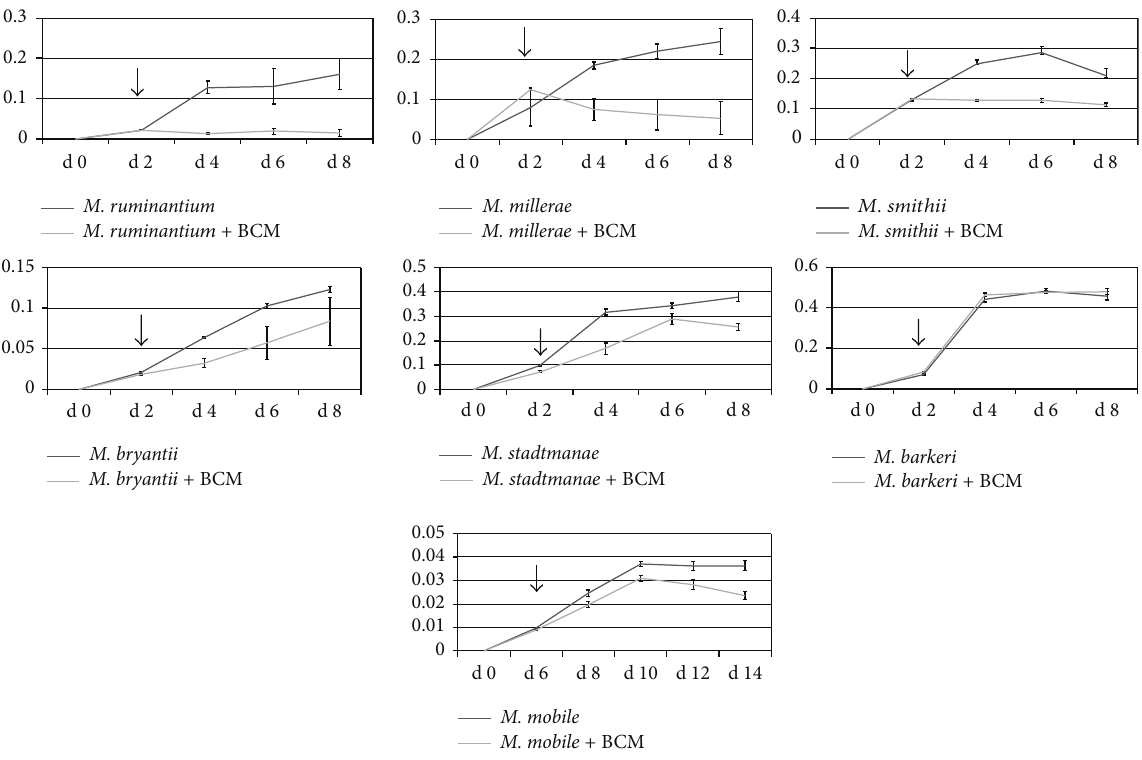
Figure 4: Assessment of effect of adding BCM on the growth (mL CH 4 /mL gas) of seven Archaea strains ( Methanobrevibacter millerae, Methanobacterium smithii, Methanobacterium bryantii, Methanobrevibacter ruminantium, Methanosarcina barkeri, Methanosphaera stadtmanae , and Methanomicrobium mobile ) studied in this